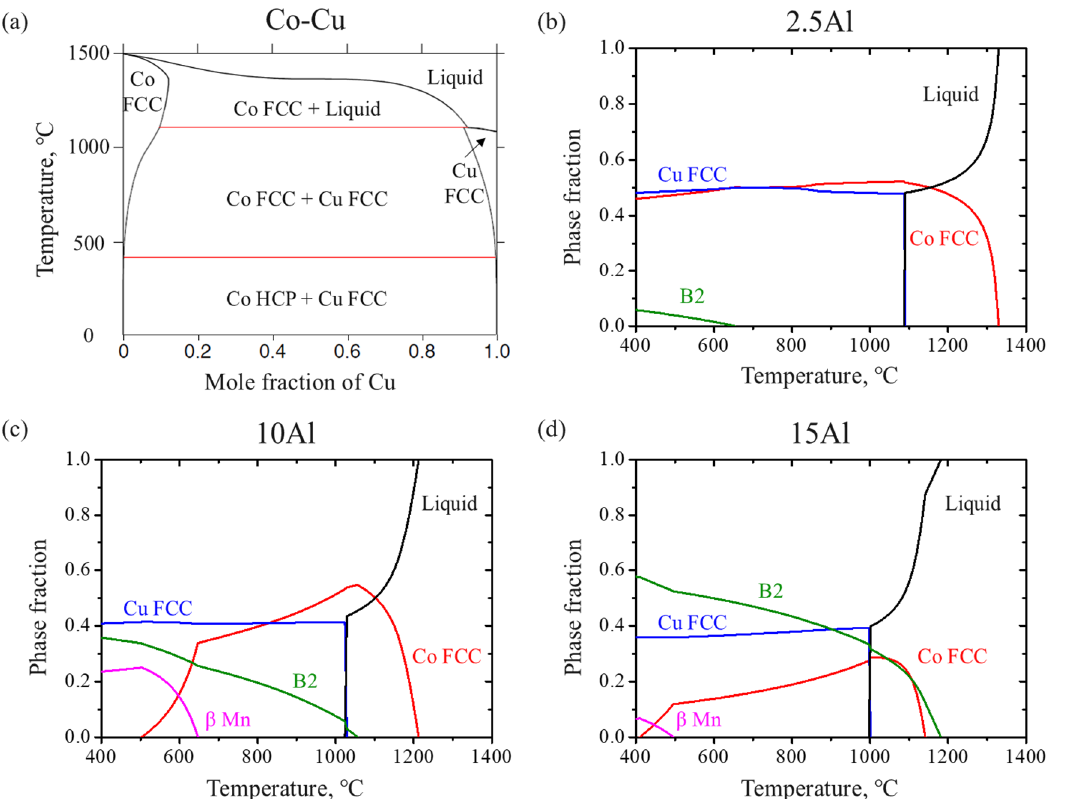
Figure 1. ( a ) Equilibrium phase diagram of Co-Cu binary system. Phase fraction as a function of temperature in the ( b ) 2.5Al, ( c ) 10Al, and ( d ) 15Al alloys.